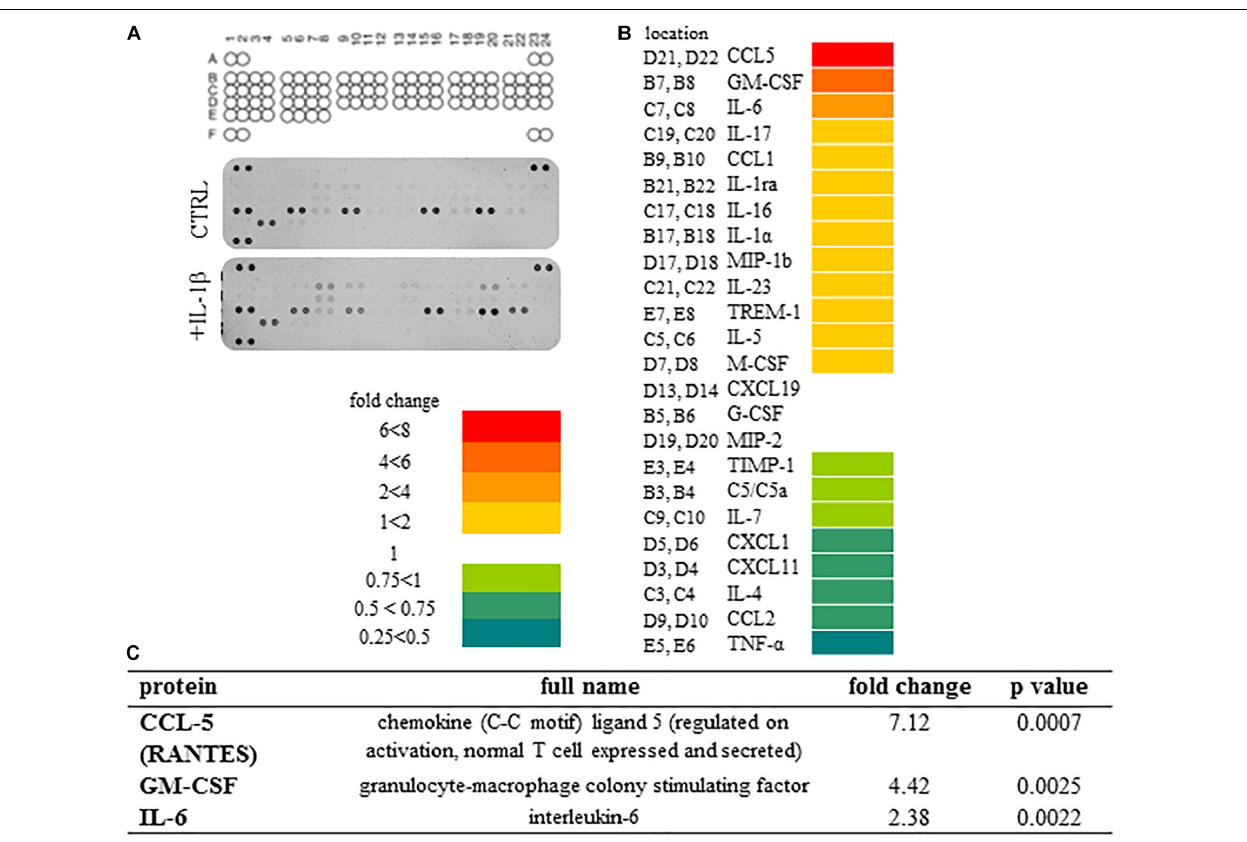
FIGURE 3 | Secretome profile of IL-1 β treated spinal astrocytes reveals the expression of 24 cytokines and chemokines. (A) Coordinates of cytokines on array membranes and developed membranes. The Proteome Profiler array used in the experiments allowed the detection of 40 cytokines, chemokines and other soluble factors. Upper panel shows array coordinates. Middle panel shows expression of cytokines/chemokines in the supernatant of unstimulated spinal astrocytes, and lower panel shows expression of cytokines/chemokines by IL-1 β stimulated astrocytes. (B) Heat map analysis of spinal astrocytic cytokine profile after 24 h of IL-1 β stimulus. Left column shows array coordinates of cytokines/chemokines in the middle column and right column shows the fold change of their amount. (C) List of cytokines/chemokines which are significantly overexpressed in the supernatant of spinal astrocyte cultures upon IL-1 β